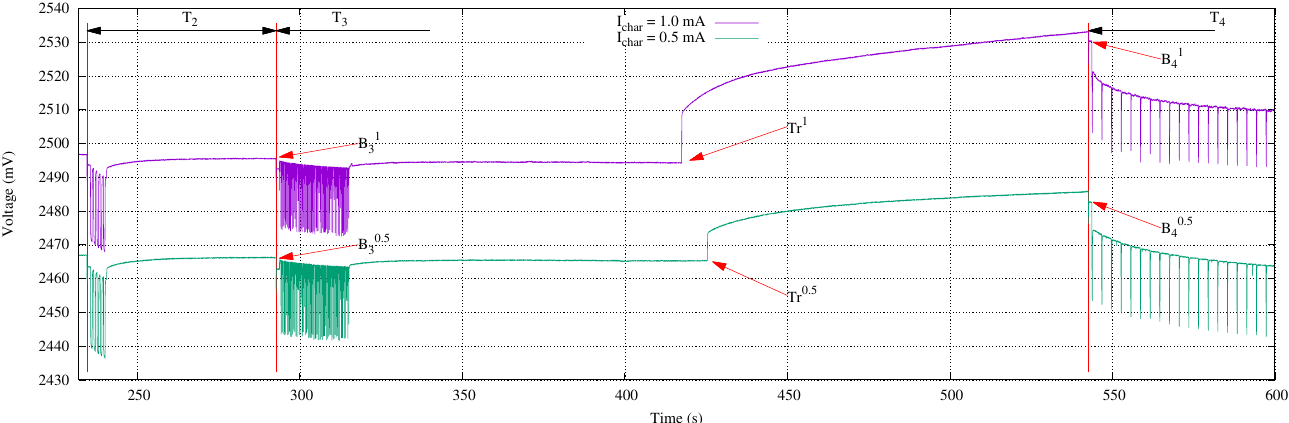
Figure 17. Experiment to switch the autonomous mode to supervisor mode using different charging